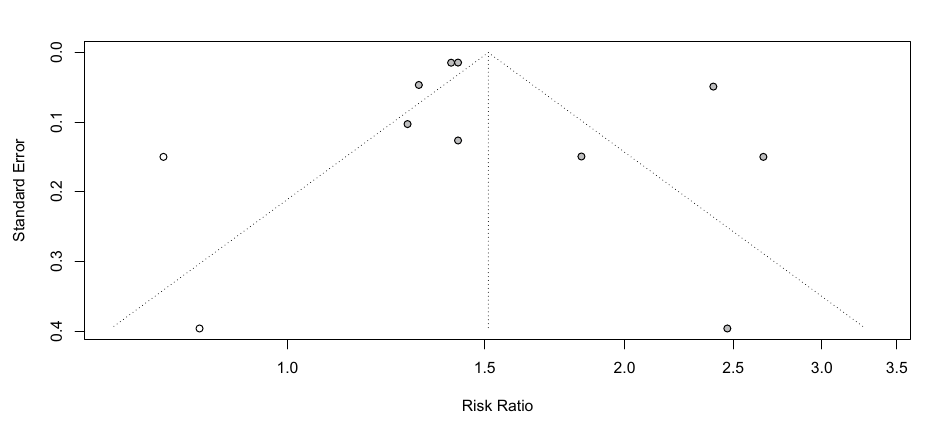
Figure 5. Funnel plots from trim and fill analysis. Duval & Tweedie trim and fill analytical method suggests that the adjusted effect estimates would fall in the range of 1.21 to 1.88, and 2 studies were added 24 .